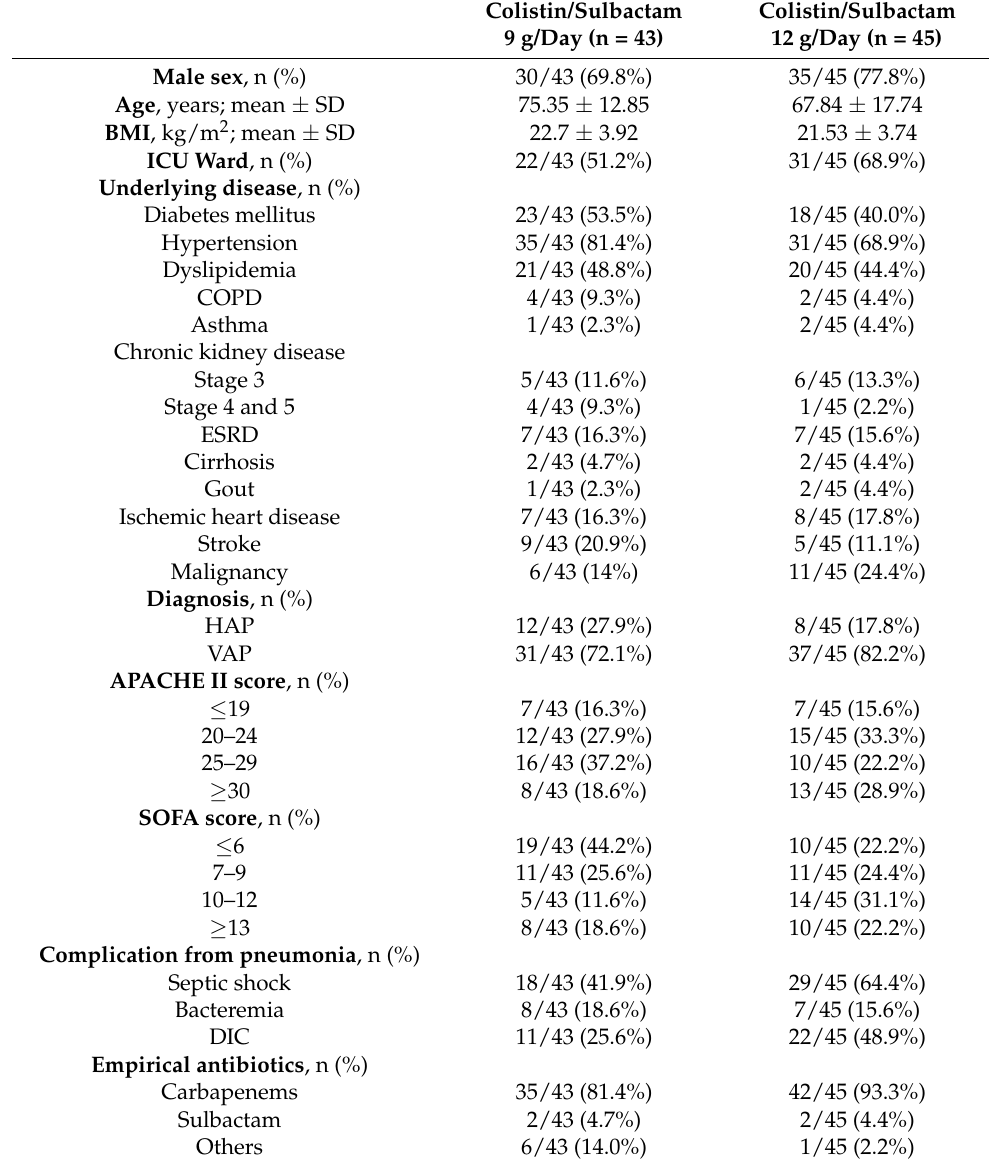
Table 1. Baseline